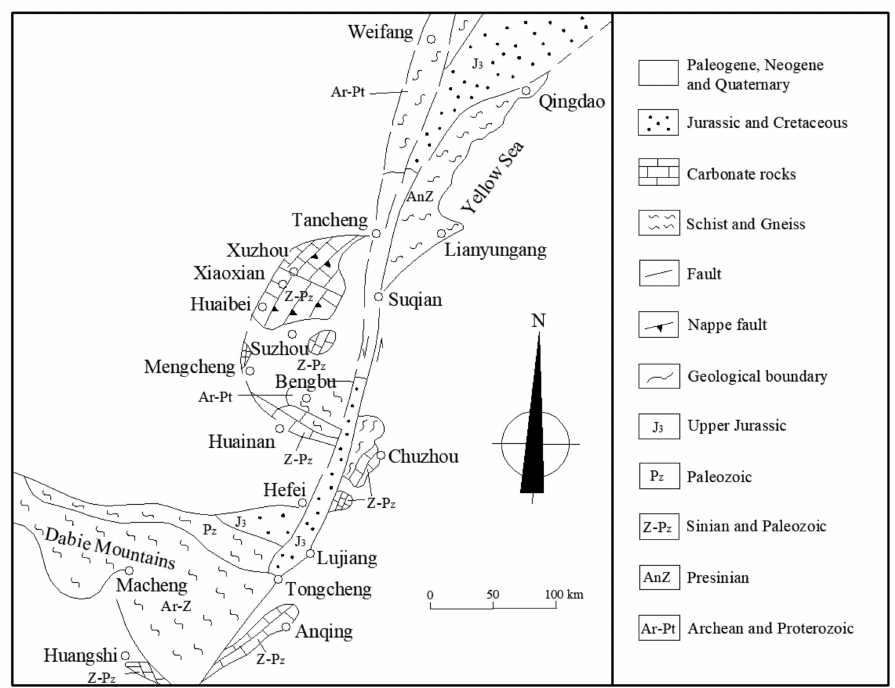
Figure 2. Geological background of the Xuzhou–Suzhou arc nappe tectonic. Modified from